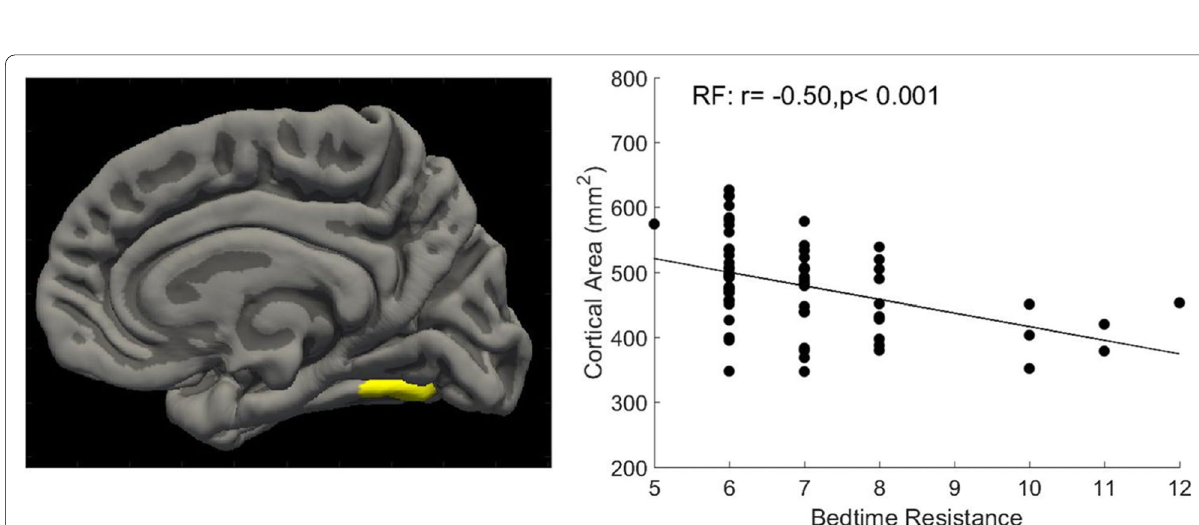
Fig. 2 The image on the left shows a cluster in the right fusiform (RF) gyrus with significant relationship (cluster‑wise corrected P bedtime resistance and cortical surface area, in standard MNI305 atlas. The scatter plot on the right illustrates the data of CSHQ subscale (bedtime resistance) vs. cortical surface area in this cluster for all subjects, and the correlation coefficient calculated by Spearman’s Partial Correlation